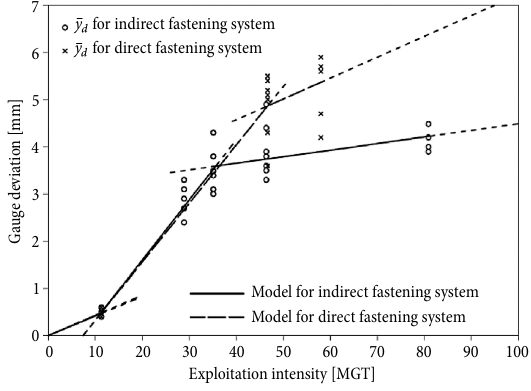
Fig. 6. Linear regression models